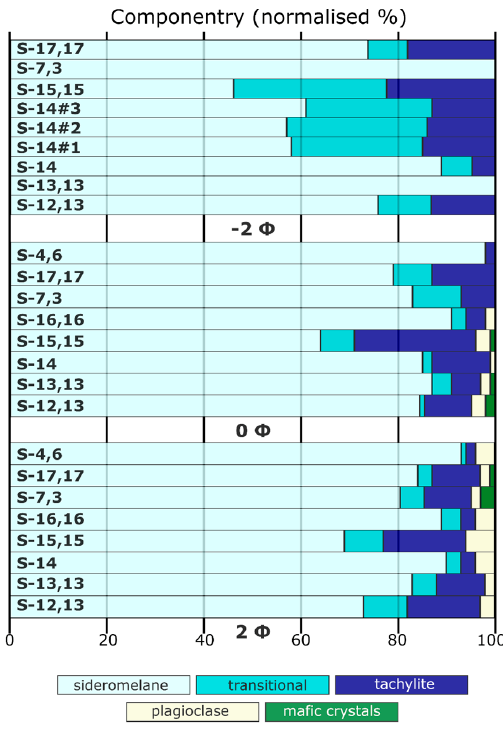
Figure 3. Componentry of the samples collected on Surtsey in 2014 (S samples) within the size fractions − 2, 0 and 2 Φ . These samples are inferred to have erupted from Surtur II in February 1964 (see Figure 1 for sample locations and Table 1 for sample